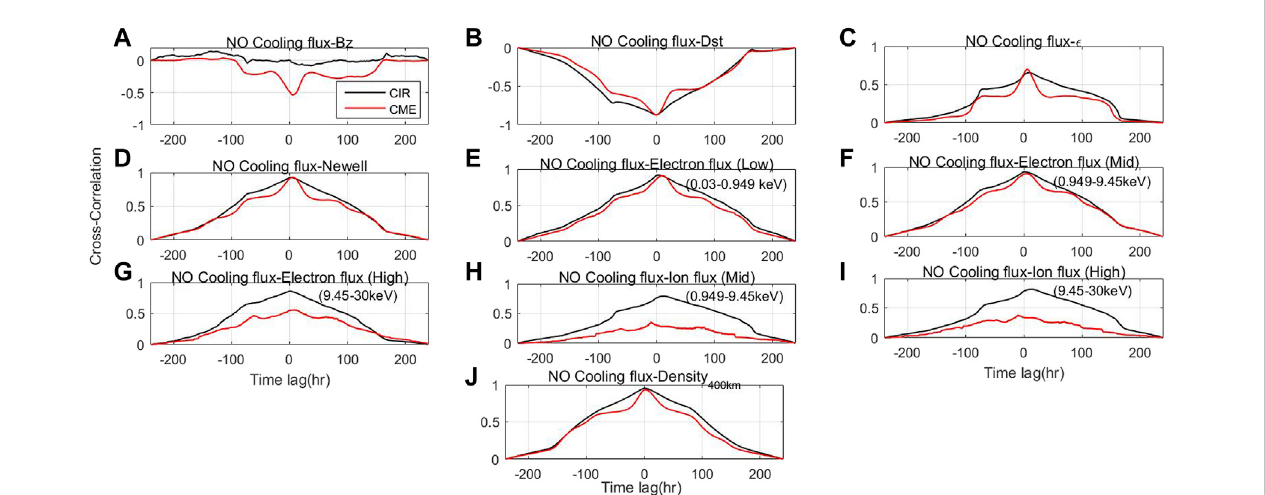
FIGURE 4 Cross-correlation between NO Cooling fl ux and other parameters. Solid black and red colors, respectively, represent the CIR-storm and CME-storm. Cross-correlationbetweencooling fl uxesand (A) IMFBz, (B) Dst-Index, (C) AkasofuCF, (D) NewellCF, (E) Lowelectron fl ux(0.03 – 0.949 keV), (F) midelectron